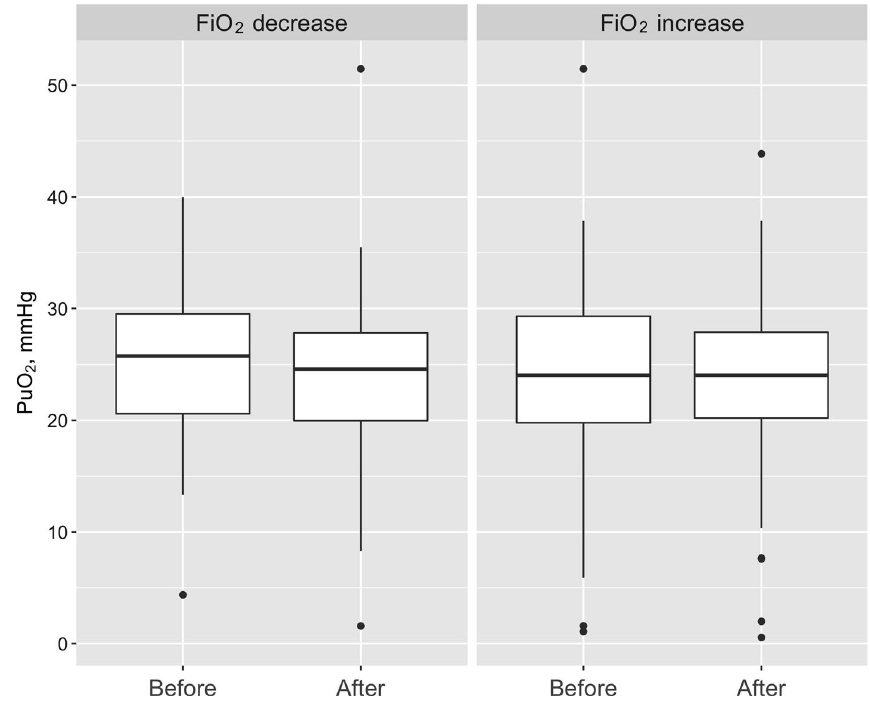
Fig. 4 Box plot representation of urinary oxygen tension before and after changes in fractional inspired oxygen. FiO 2 : fractional inspired oxygen; PuO 2 : urinary oxygen